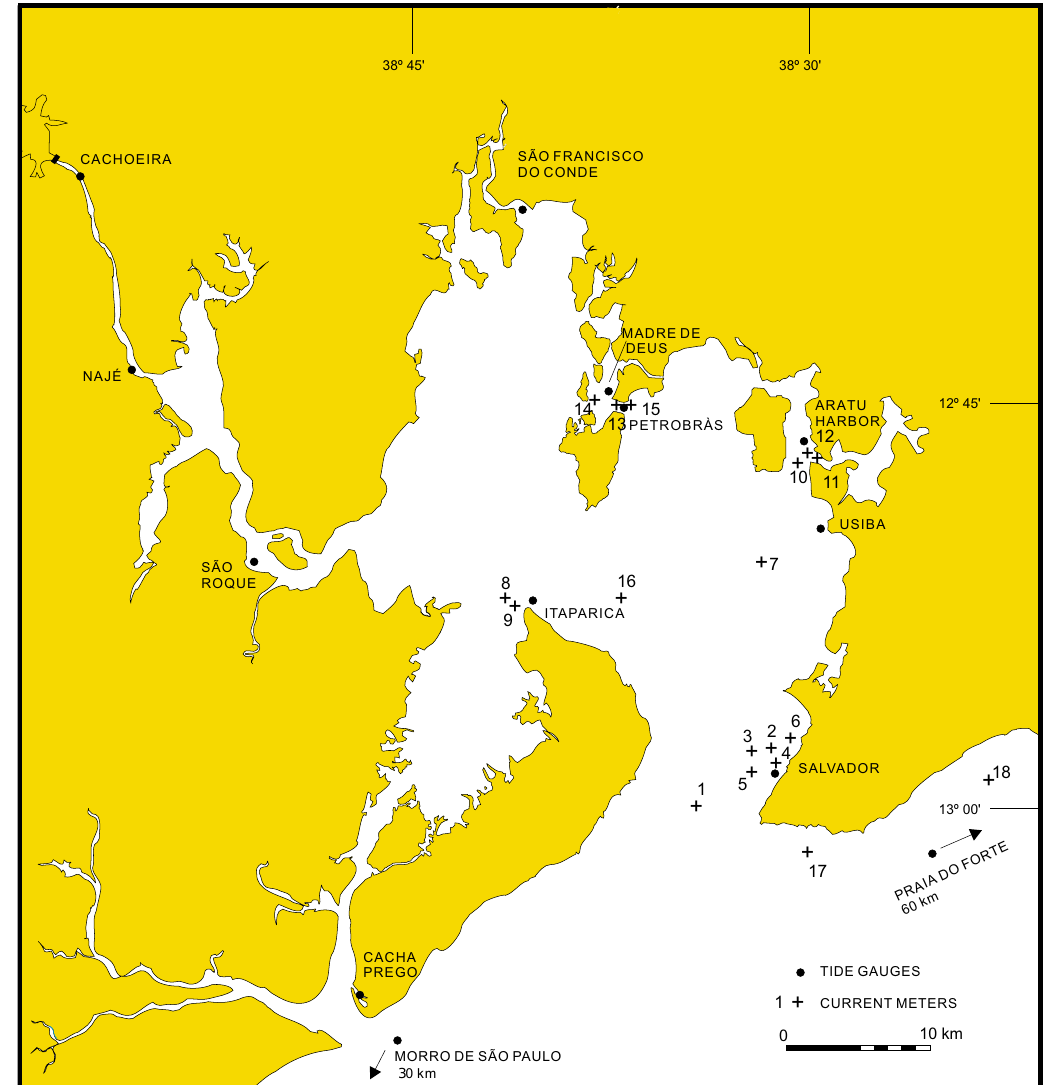
Fig. 3 – Location of the tidal and tidal current measurement